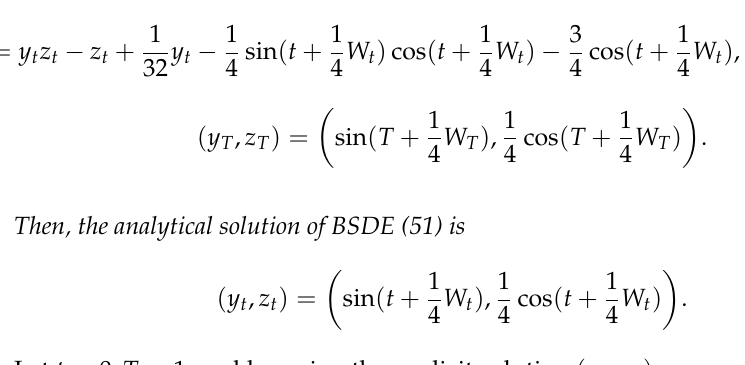
scheme D scheme E scheme F